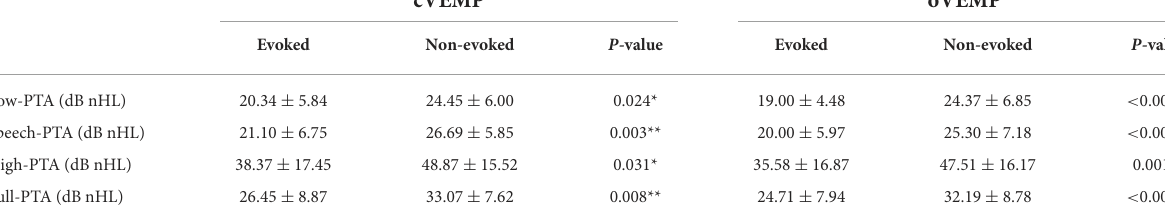
TABLE 2 Comparison of PTAs between VEMP evoked and non-evoked groups.